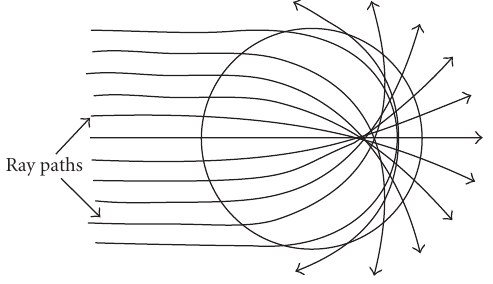
Figure 1: A set of possible ray paths in a Maxwell’s fish-eye.